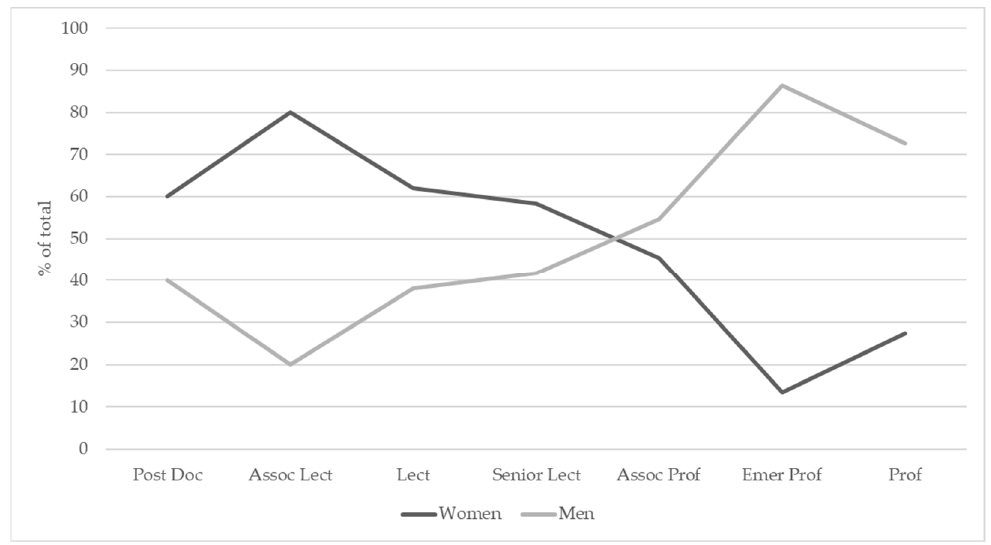
Figure 1. Scissor diagram showing the gender distribution within different academic levels in Australian and New Zealand veterinary